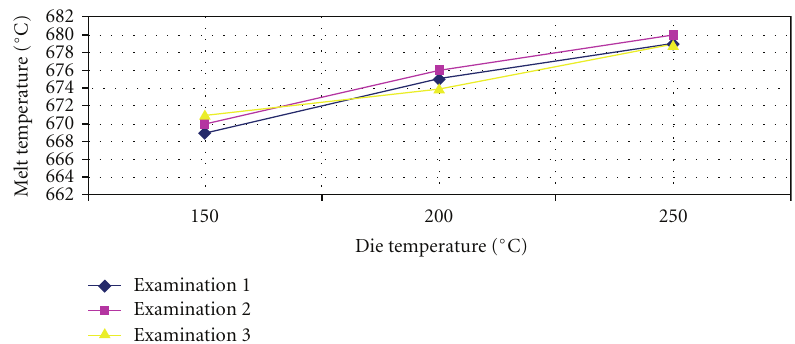
Figure 2: Melt temperatures at die entrance and start injection versus die temperatures.